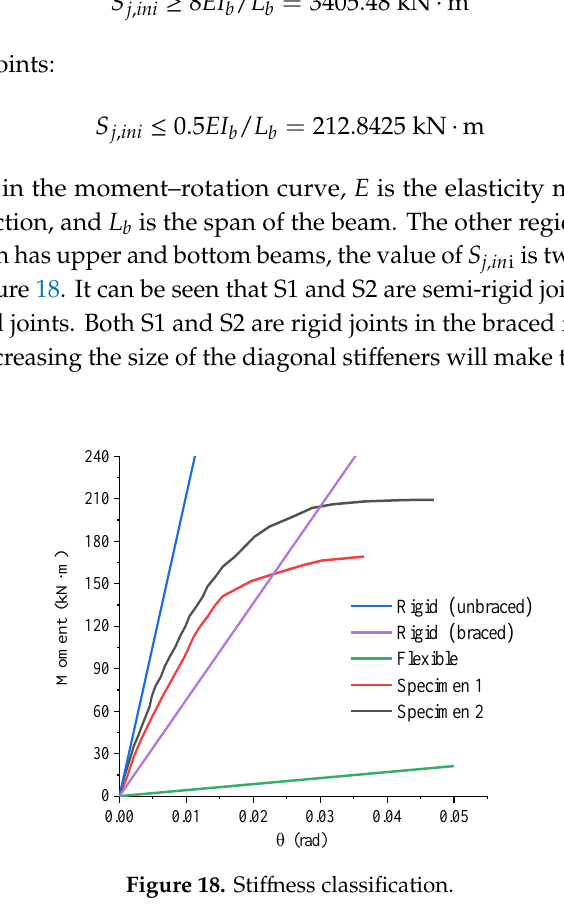
Figure 20. Load–strain curve of S1, area D.